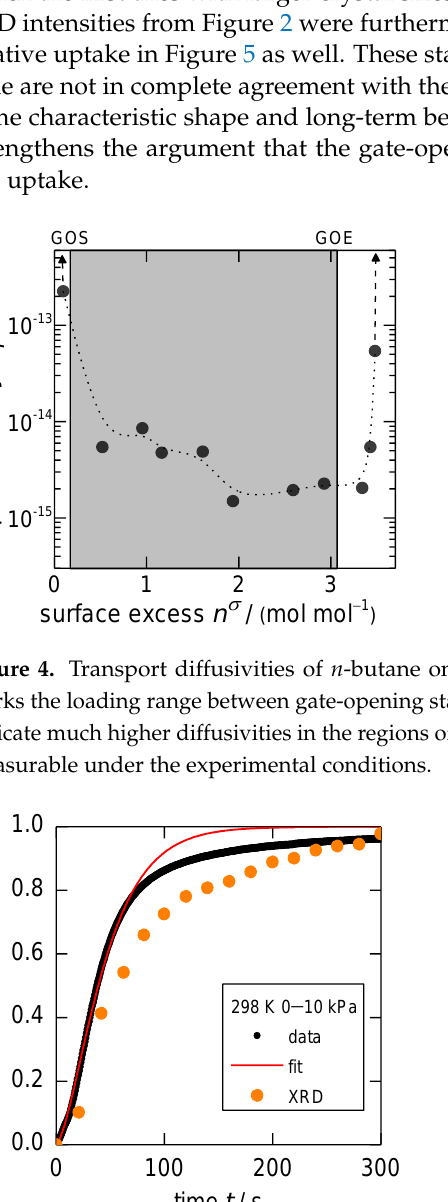
Figure 5. Gravimetric uptake of n -butane on 1 at 298 K after a pressure step 0 → 10 kPa, the fitted model presented in this work and the uptake as derived from PXRD data measured under the same conditions, representing the state of structural transition in dependence of time.